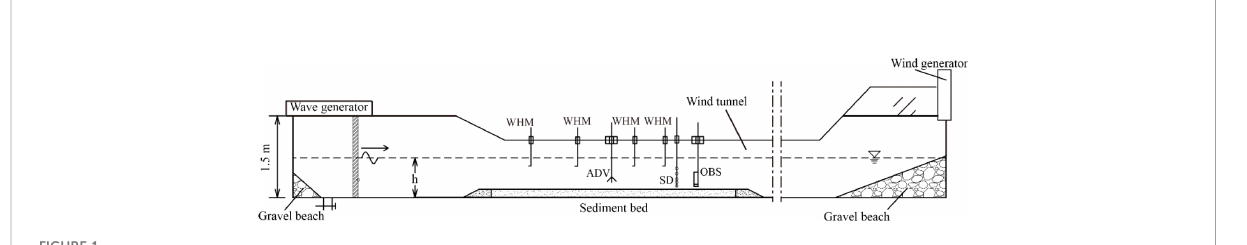
FIGURE 1 The experimental design and schematic of the wind-wave fl